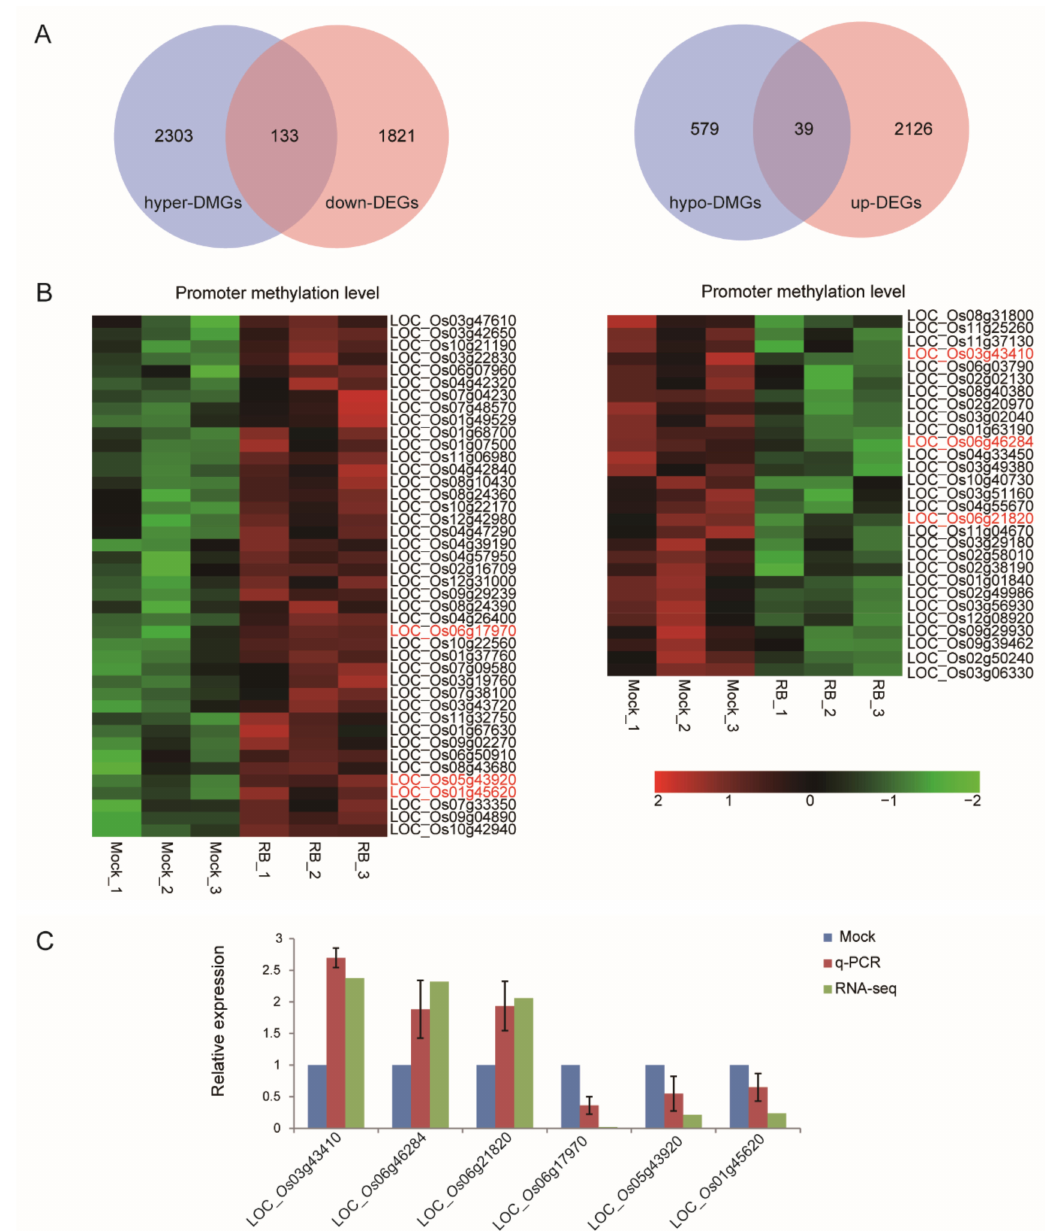
Figure 4. Combinational analysis of genes that changed in DNA methylation and transcriptional expression. ( A ) Venn diagrams display the negative association between DNA methylation region (DMR)-associated genes ( p < 0.05) and di ff erentially expressed genes ( p < 0.05) induced by RBSDV. ( B ) Heatmap represents the methylation levels of 71 RBSDV-responsive genes. ( C ) RT-qPCR validated six randomly selected RBSDV-responsive mRNAs from up-regulated and down-regulated candidate genes. RT-qPCR results were normalized to the data from RBSDV-free leaves, respectively. Vertical bars represent standard deviation (SD) of the mean of five biological